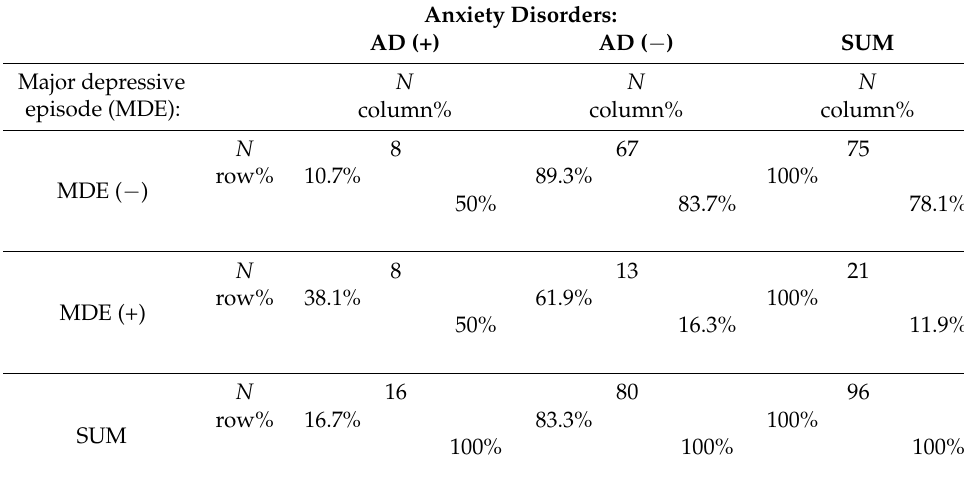
Table 2. Comorbidity of MDE with AD in the group of epileptic patients ( n = 96). Anxiety Disorders: AD (+) AD ( − ) SUM Major depressive